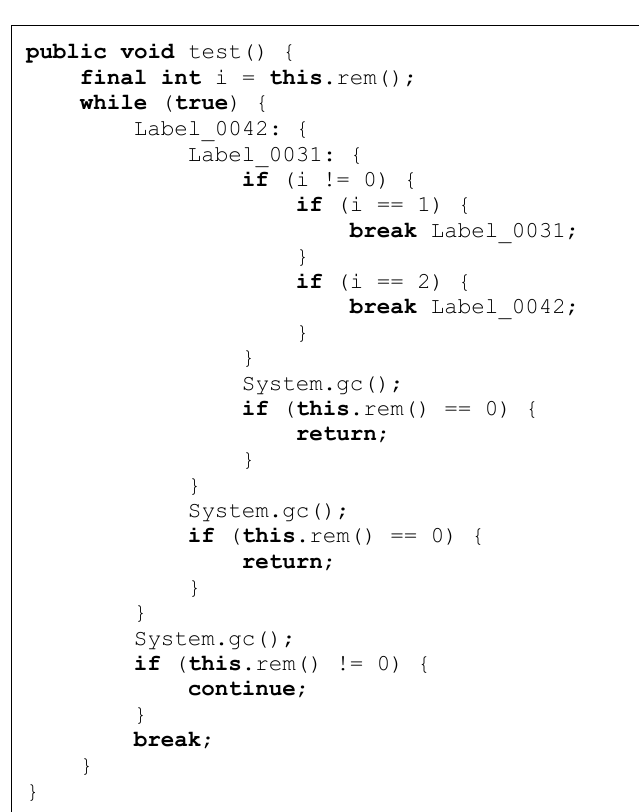
Fig. 16. Procyon decompilation